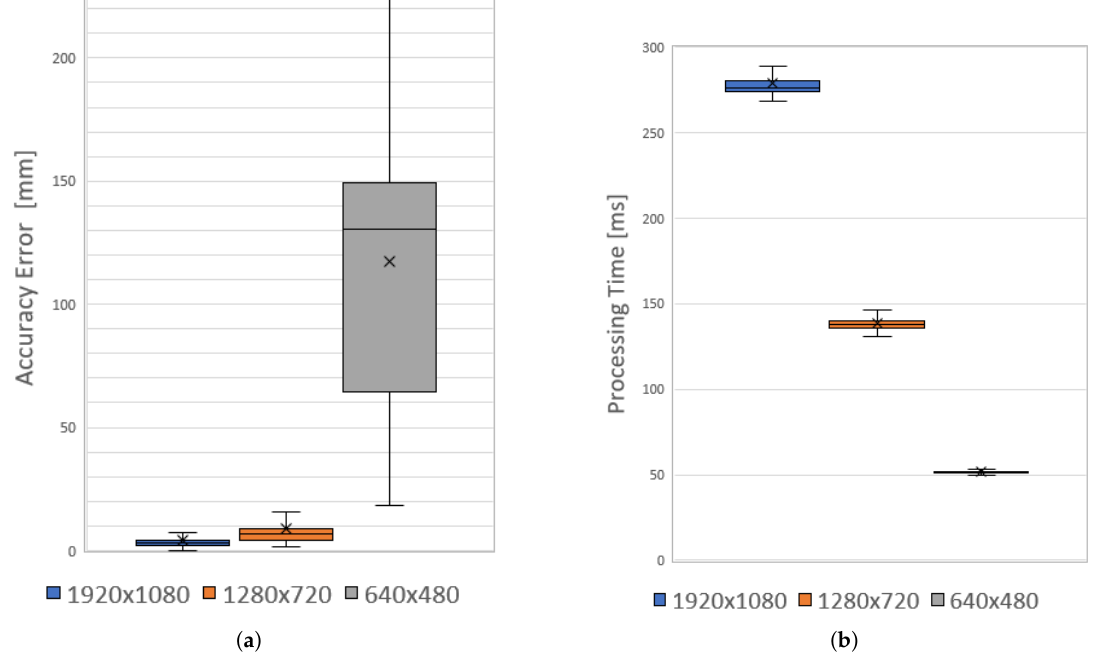
Figure 7. Simulation results: ( a ) detection accuracy error; ( b ) processing time.